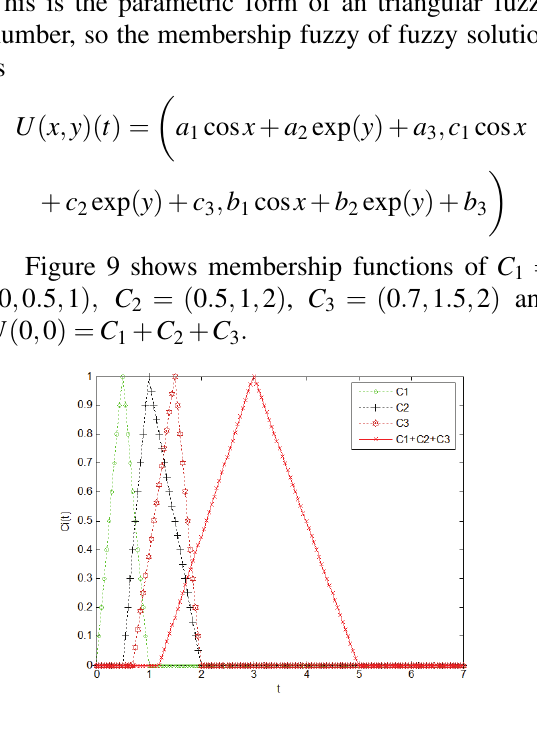
Fig. 9. The curves of some triangular fuzzy numbers.